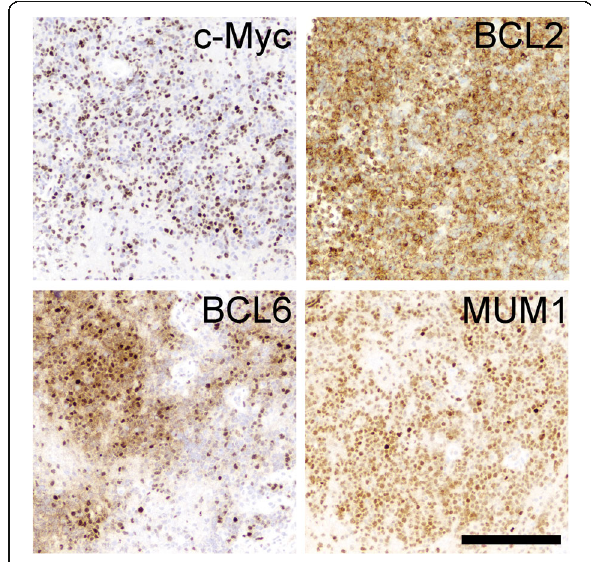
Fig. 4 Additional immunohistochemistry from the second